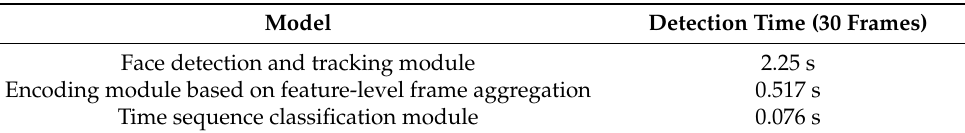
Table 5. Detection time expenditure of each